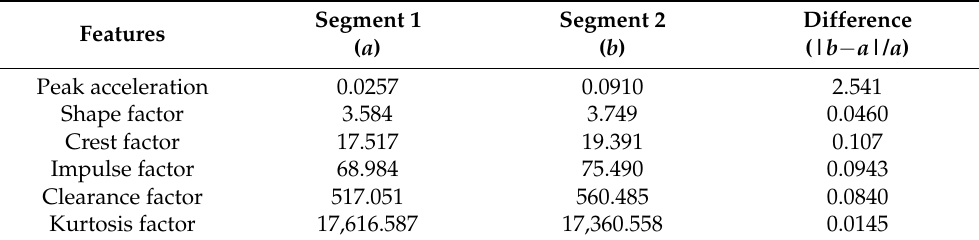
Table 3. Six features of the two segments and their relative differences in the current stage of monitoring.